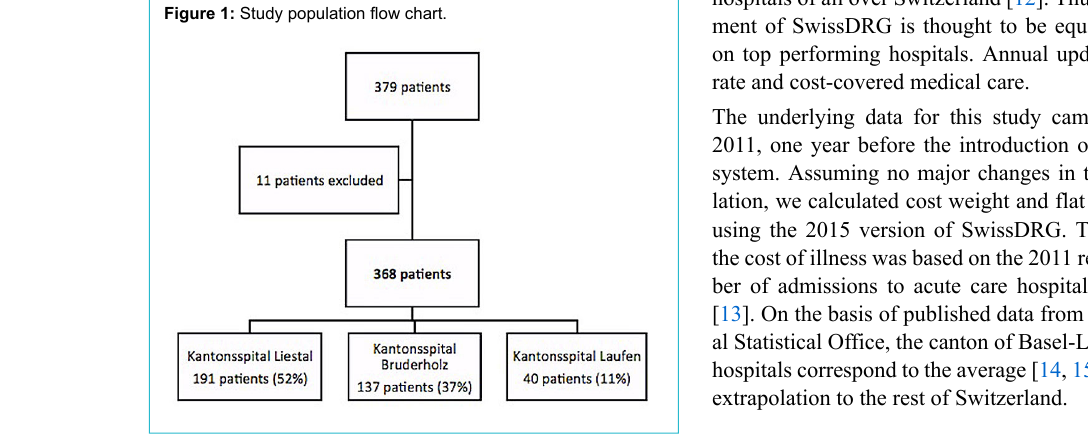
Figure 1: Study population flow